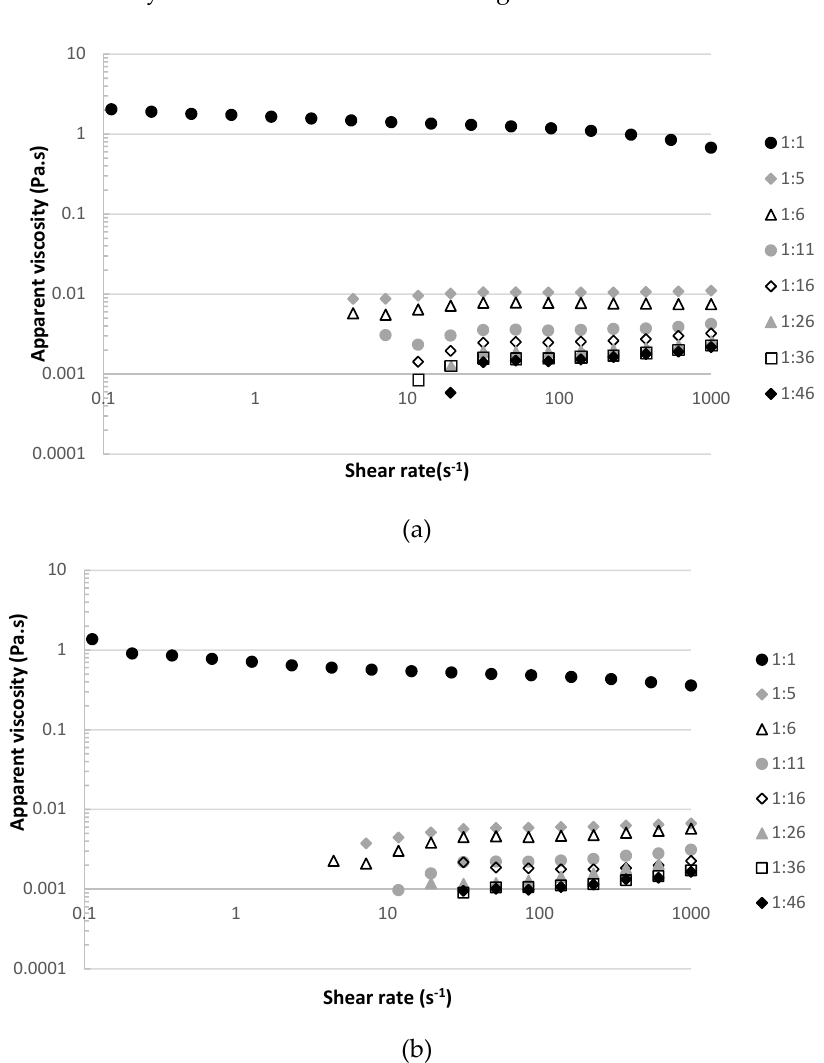
Figure 2. Apparent viscosity (Pa·s) against the shear rate (s − 1 ) of the raw material arabinoxylans extract diluted at different dilution ratios: ( a ) at 20 °C and ( b ) at 40 °C.